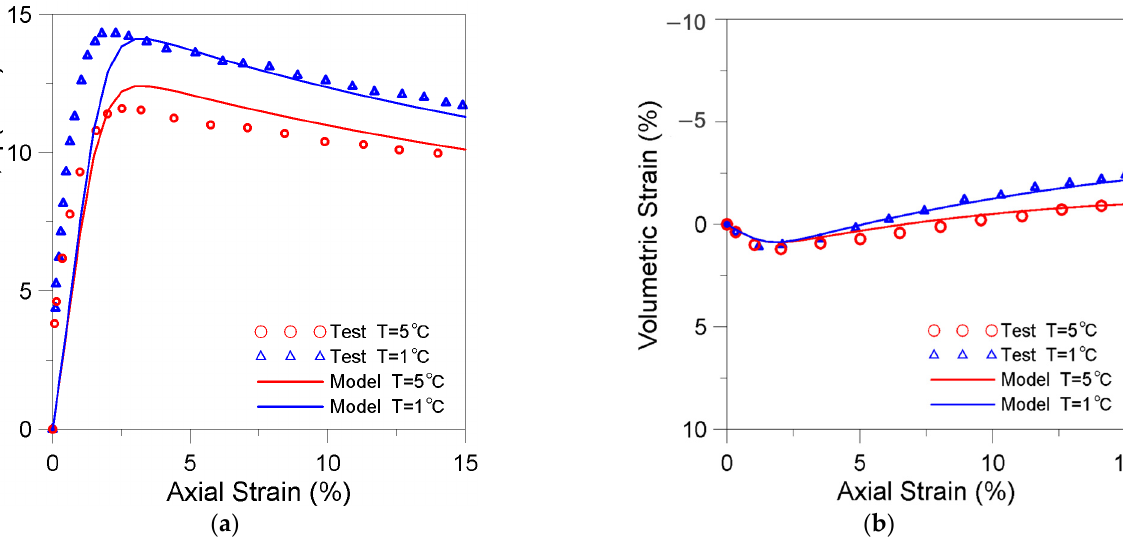
Figure 9. Modeling the tests reported in Hyodo et al. [31] at different temperatures. ( a ) Deviatoric stress versus axial strains; ( b ) volumetric strain versus axial strains.